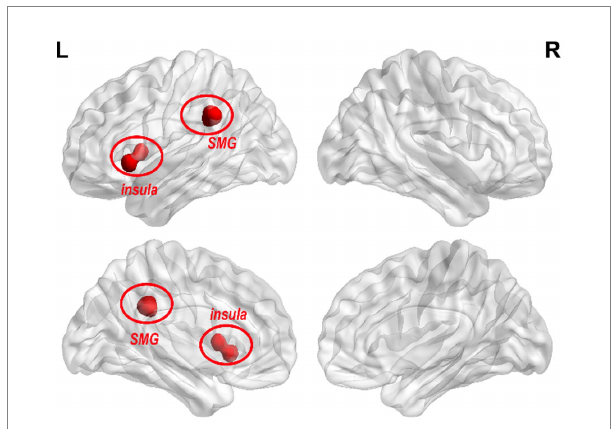
FIGURE 3 Changes of LC FC in the RA group compared with the SA group after treatment. The red color in the figure indicates the brain areas with LC FC increases in the RA group compared with the SA group (GRF correction, p -voxel < 0.001, p -cluster < 0.05, cluster size > 26).